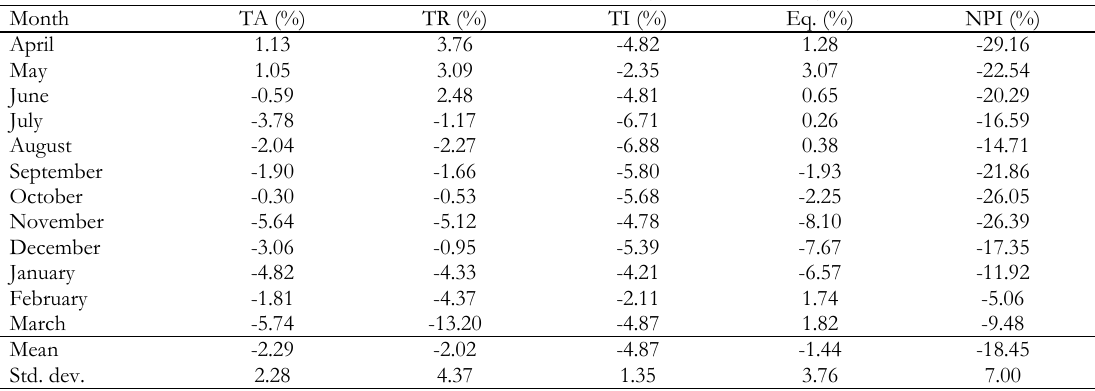
Table 2. Changes in the Growth Rate (y-o-y) of Total Asset (TA), Technical Reserve (TR), Total Investment (TI), Equity (Eq.), and Net Premium Income (NP) of General